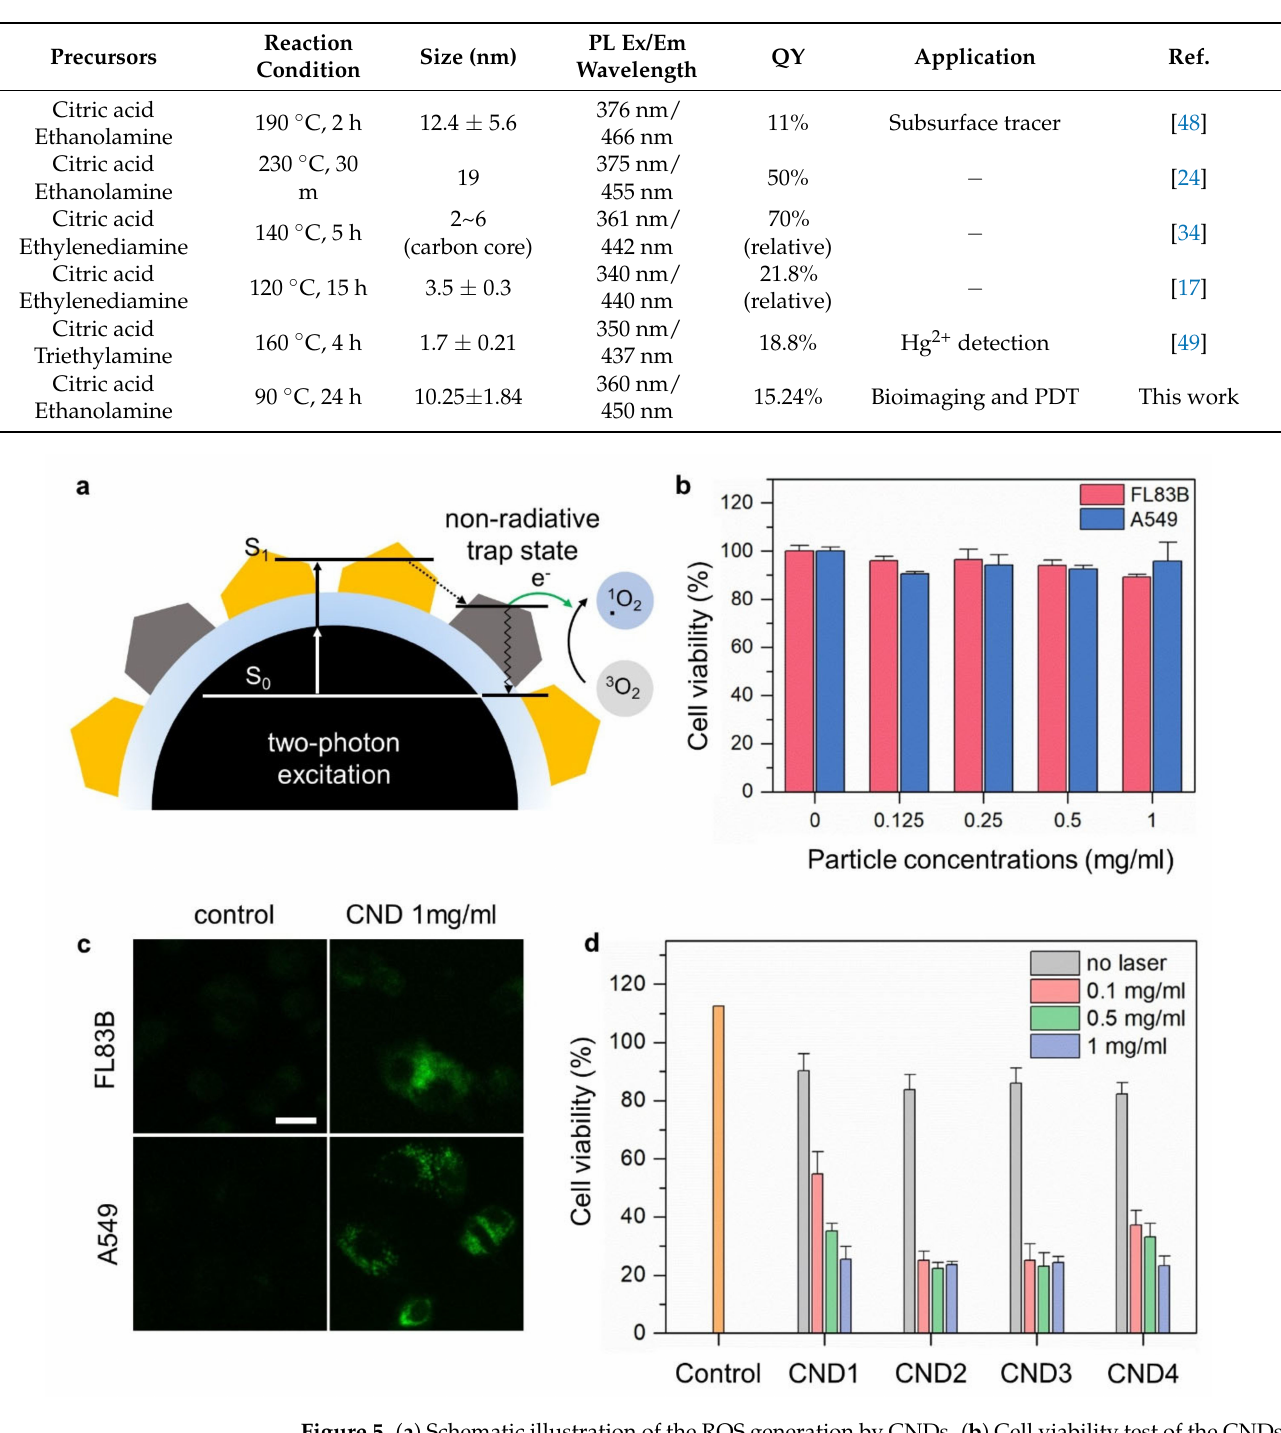
Table 2. Brief literature review of CNDs derived from the mixture of CA and amine derivatives.